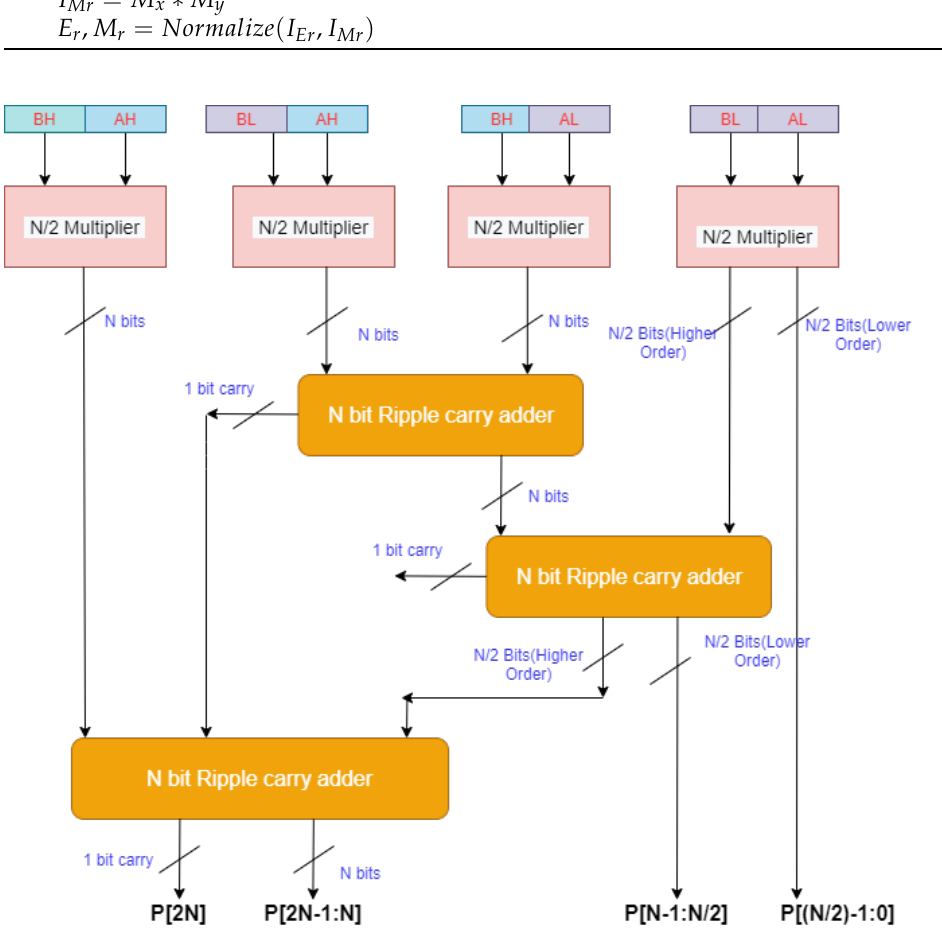
Figure 16. General Structure of N × N Vedic